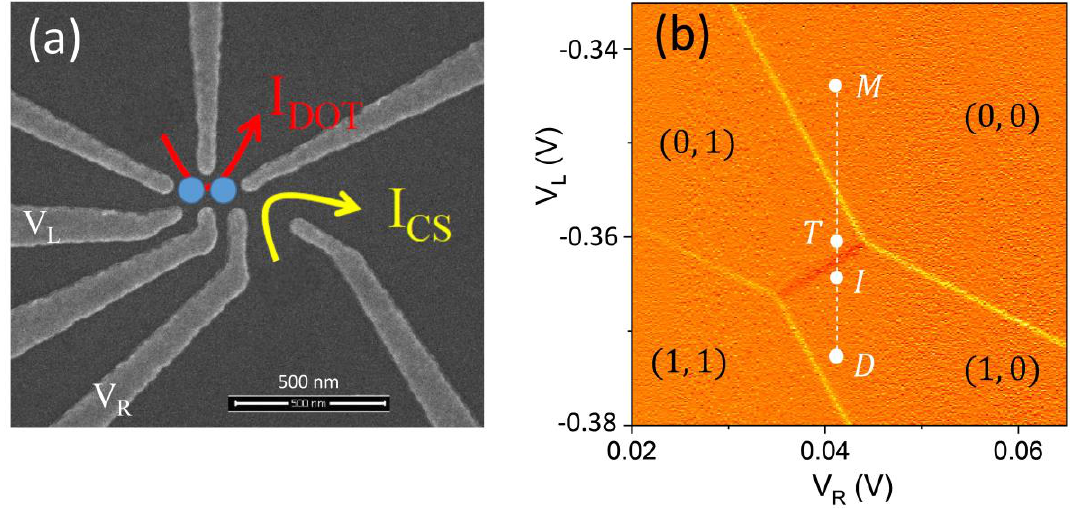
Figure 1. ( a ) An SEM image of the double quantum dot (DQD) device similar to the one used in this work but without the global gate laid over the fine surface gates. The yellow and red arrows show the direction of the charge sensing and inter-dot currents. The blue circles indicate the approximate locations of the two quantum dots. The labeled V L and V R gates are used to control the dot occupation and the detuning energy during the spin qubit manipulations. ( b ) An example of the charge stability diagram measured via the charge sensor current, dI CS /dV L . Each region is labeled with the left and right dot hole occupations (n L , n R ). The detuning trajectory is indicated as the dashed white line with the detuning points of the control pulse sequence during the manipulation and readout protocol labeled as measurement (M), transfer (T), initialization (I), and (D)